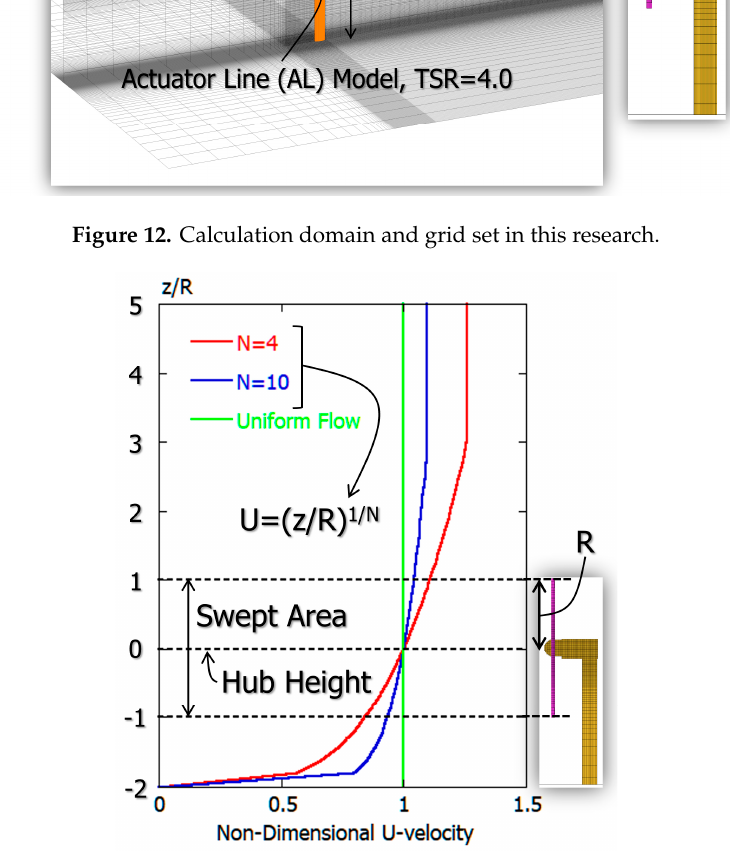
Figure 13. Three types of inflow shear set at inflow boundary.